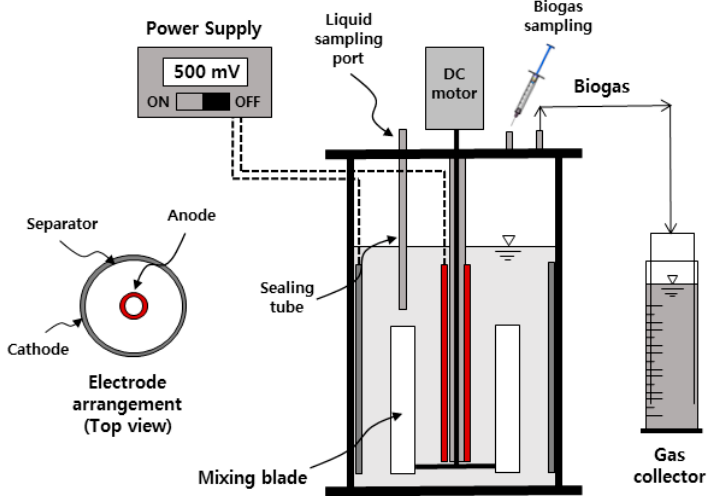
Figure 1. Schematic diagram of the bioelectrochemical anaerobic batch reactor.